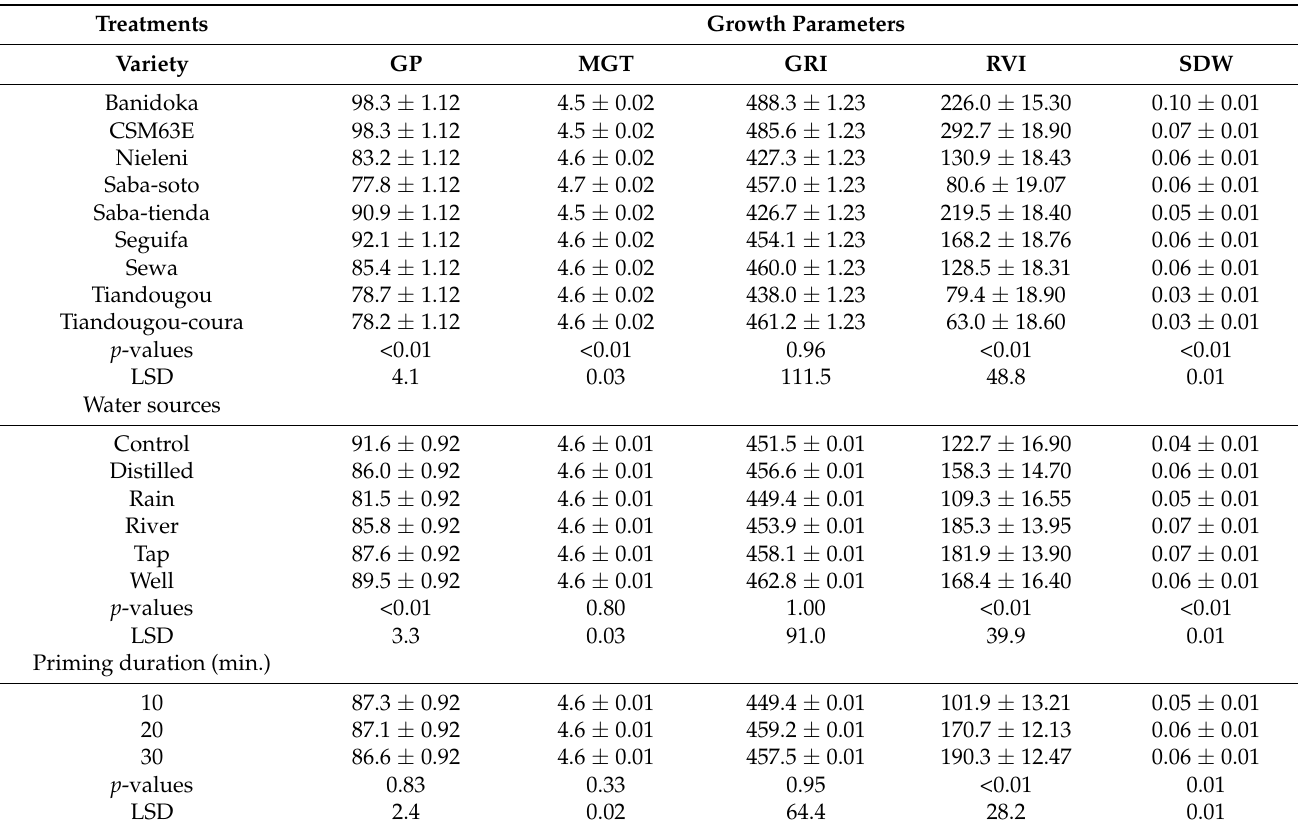
Table 8. Effect of water priming at different durations and with water from different sources on seed germination and growth parameters of nine varieties of sorghum in hot water.